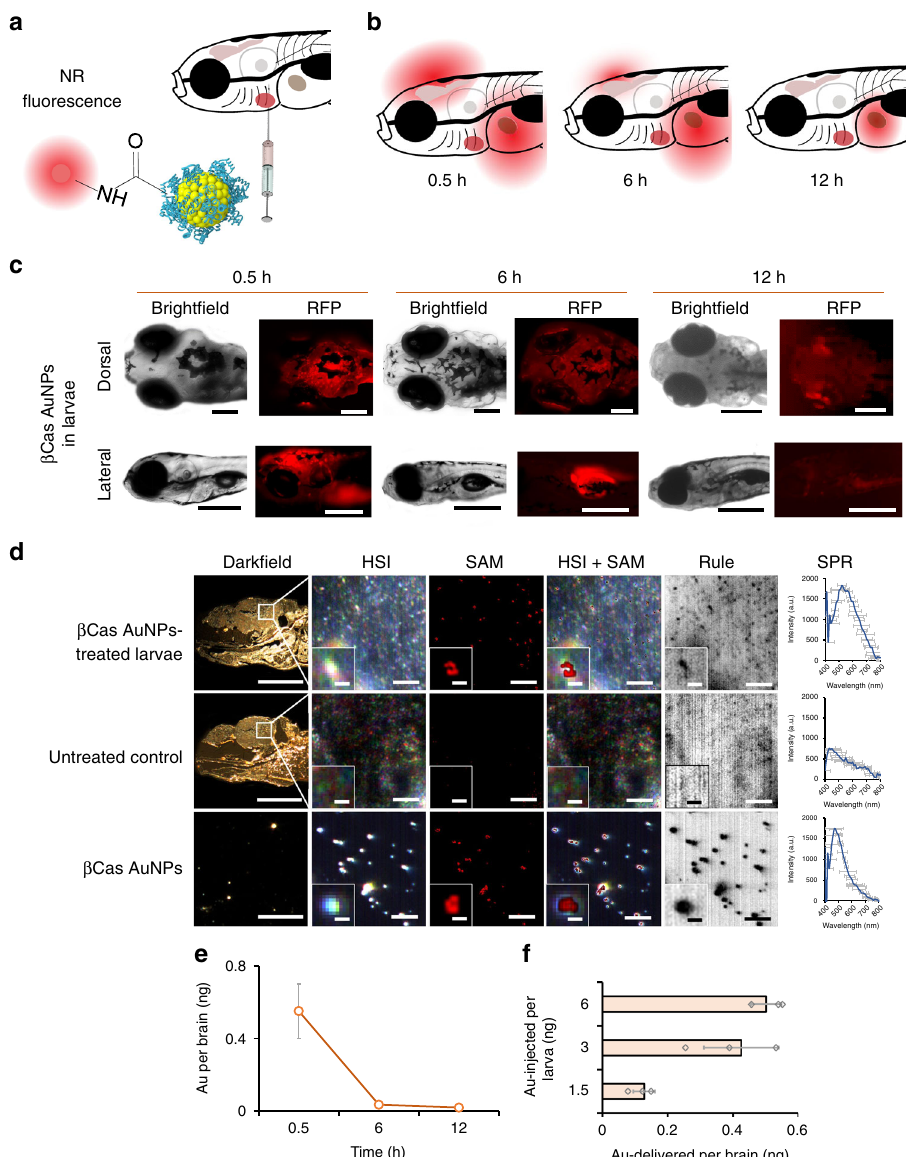
Fig. 4 In vivo biodistribution of β Cas AuNPs in zebra fi sh larvae. a β Cas AuNPs were conjugated with neutral red and injected to zebra fi sh larvae (5 day old) via the intracardiac route in a dose equivalent to 3 ng Au per 4.5 ng β Cas. b Labeled β Cas AuNPs were traced for in vivo distribution at 0.5, 6, and 12 h in dorsal and lateral positions ( c ). Bright fl uorescence was observed from the brain 0.5 h after AuNP administration. However, fl uorescence was eliminated from the cerebral region in 6 h, while it took 12 h to eliminate from the body (scale bars: 200 µ M). d Tissue microtome of zebra fi sh brain was subjected to HSI imaging. Spectral angular mapping (SAM) images were built from HSI by scanning against the β Cas AuNPs spectral library. SAM and Rule images colored the pixels as red and black, respectively, that have matching spectra of β Cas AuNPs. Zebra fi sh larvae with β Cas AuNPs in the brain presented black spots in Rule images and red pixels in SAM images. SPR spectra with peak ~530 nm were observed in the brain of β Cas AuNPs treated larvae. No such spectra were recorded for control larva (scale bars: dark fi eld 200 µ M; HSI, SAM, HSI + SAM, Rule: 10 µ M; inset scale bar: 2 µ M; scale bar for β Cas AuNPs: 10 µ M, inset scale bar: 0.5 µ M). e ICP MS analysis, where the AuNP concentration was the highest in the larval brain at 0.5 h, i.e., equivalent to 0.6 ± 0.1 ng of Au, and dropped to 0.05 ± 0.01 and 0.02 ± 0.008 ng at 6 and 12 h, respectively ( n = 10). f Dose – response relationship between the amount of AuNPs injected vs. the amount of AuNPs delivered across the brain ( n = 10). Signi fi cantly ( p < 0.05) increased amount of Au was delivered when intracardiac dose of AuNPs was increased from 1.5 to 3 ng equivalent. However, increasing the dose from 3 to 6 ng did not improve AuNP delivery across the BBB, indicating a dose saturation. Error bars represent the standard deviation. Source data are provided as a Source Data fi